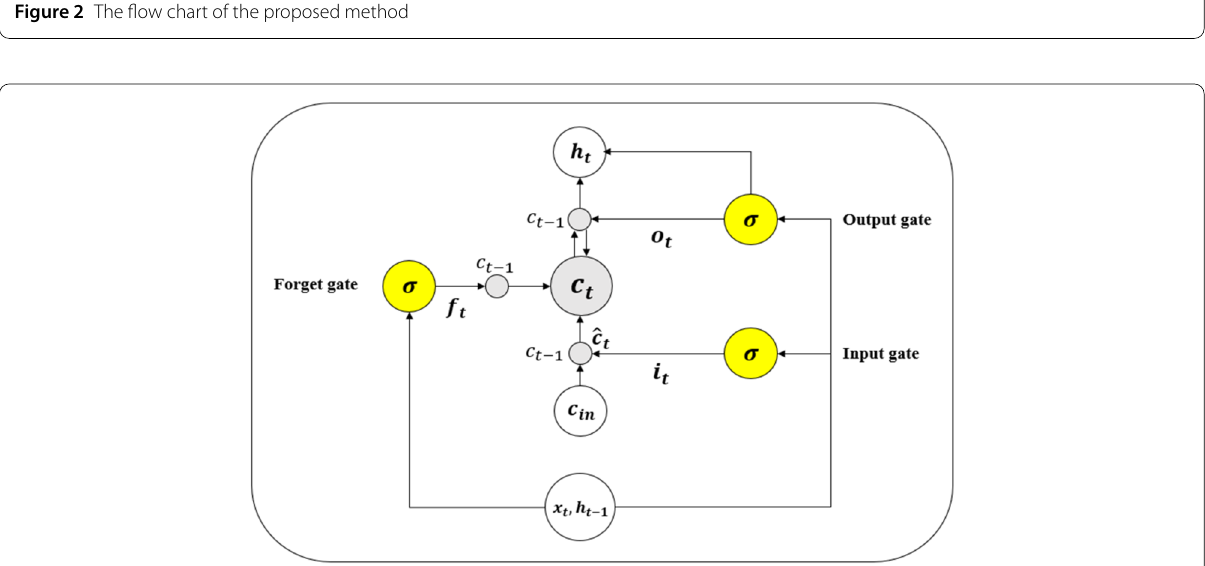
Figure 3 The schematic diagram of an LSTM cell